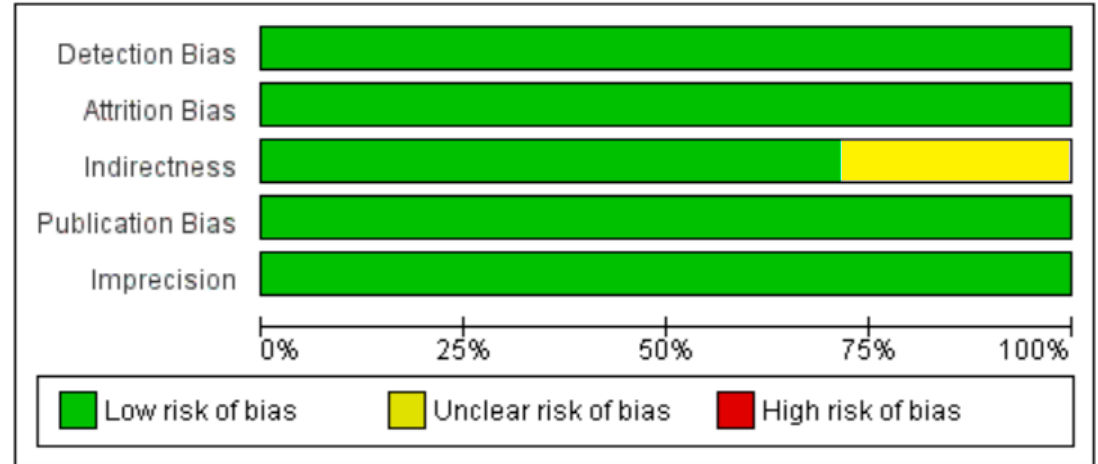
Figure 12. Risk of bias assessment for diabetic subject studies (plus sign shows low risk, minus sign shows high risk, and question mark shows unknown bias) [18,53,77,102,107–109].